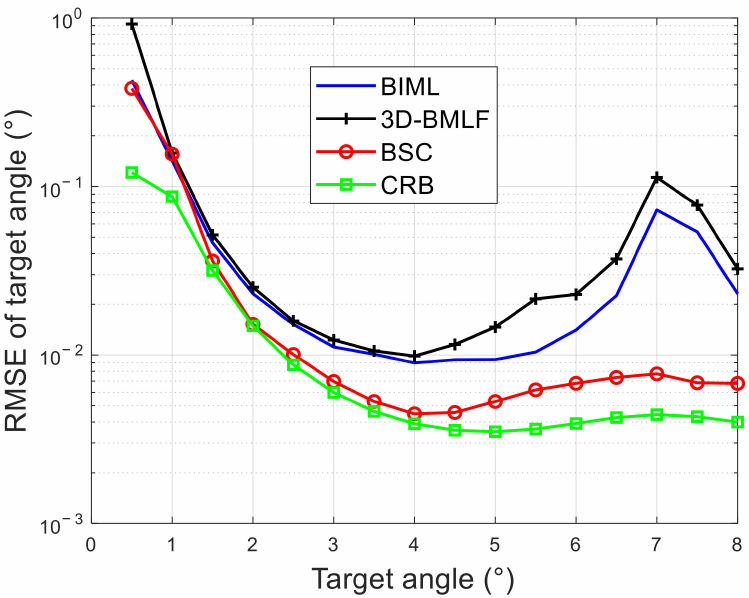
Figure 3. The RMSEs of the target angle for the three algorithms against the